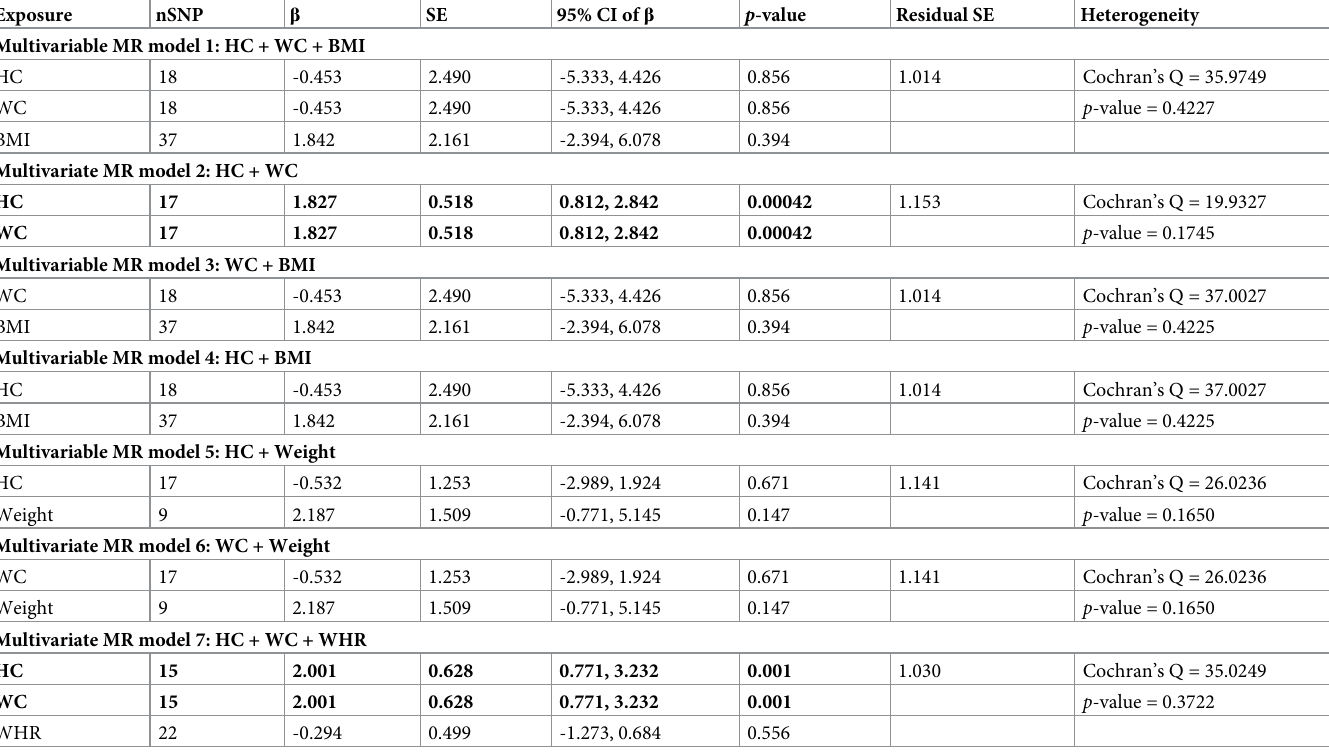
Table 6. Findings from multivariable Mendelian randomization analyses with multiple anthropometric markers as exposures and polycystic ovarian syndrome as the